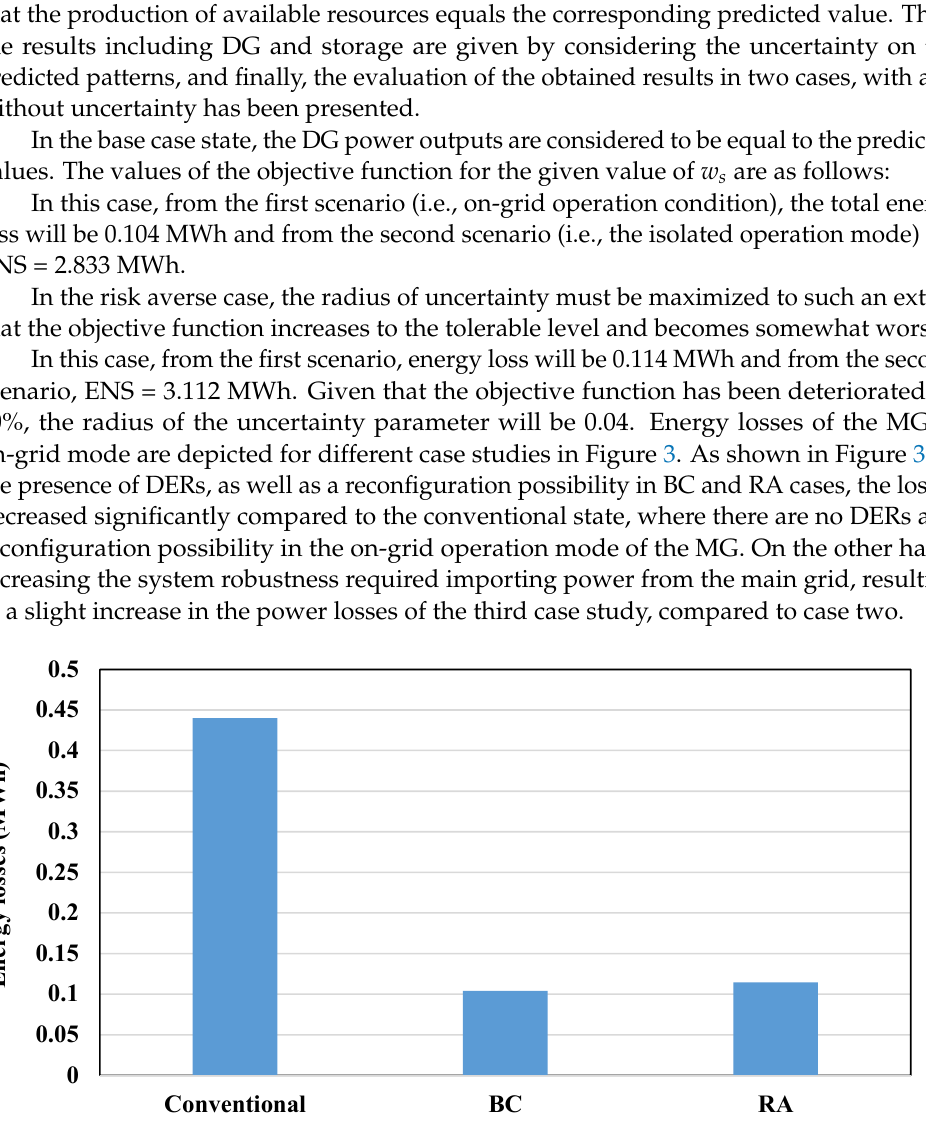
Figure 4. Energy not supplied in different case studies (off-grid).